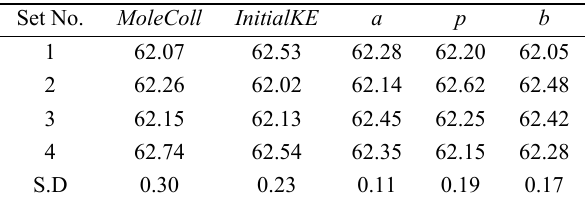
Table 7 Average values for different parameters.